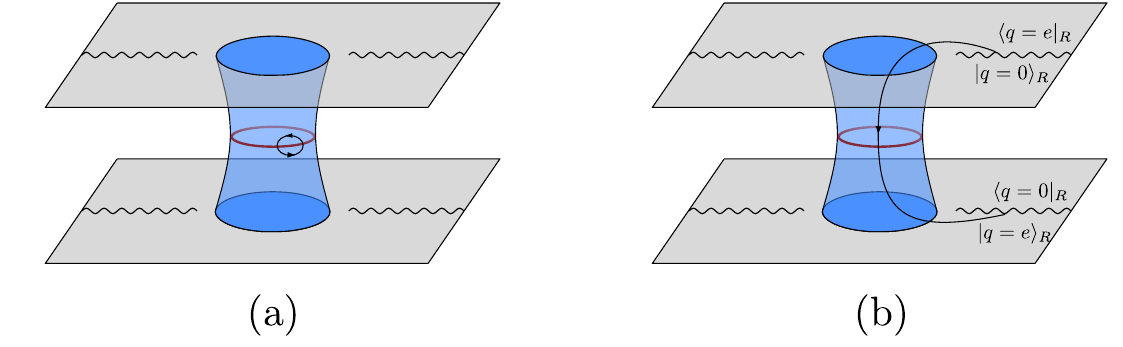
Figure 7 . Two virtual processes that contribute to Z 2 ( α ) . (a) The smaller, contractible loop does not give a contribution that depends on α , since on the red circle there is both a particle and an anti-particle. (b) The larger loop is non-contractible, contributes to the off-diagonal part tr [ ρ e, 0 ρ e, 0 ] (see section 3.2), and therefore to the α dependence. This should be compared with figure